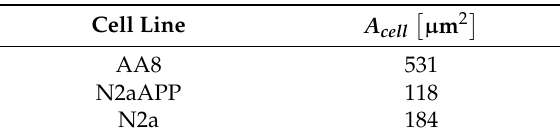
Table 1. Cell area of the studied cell